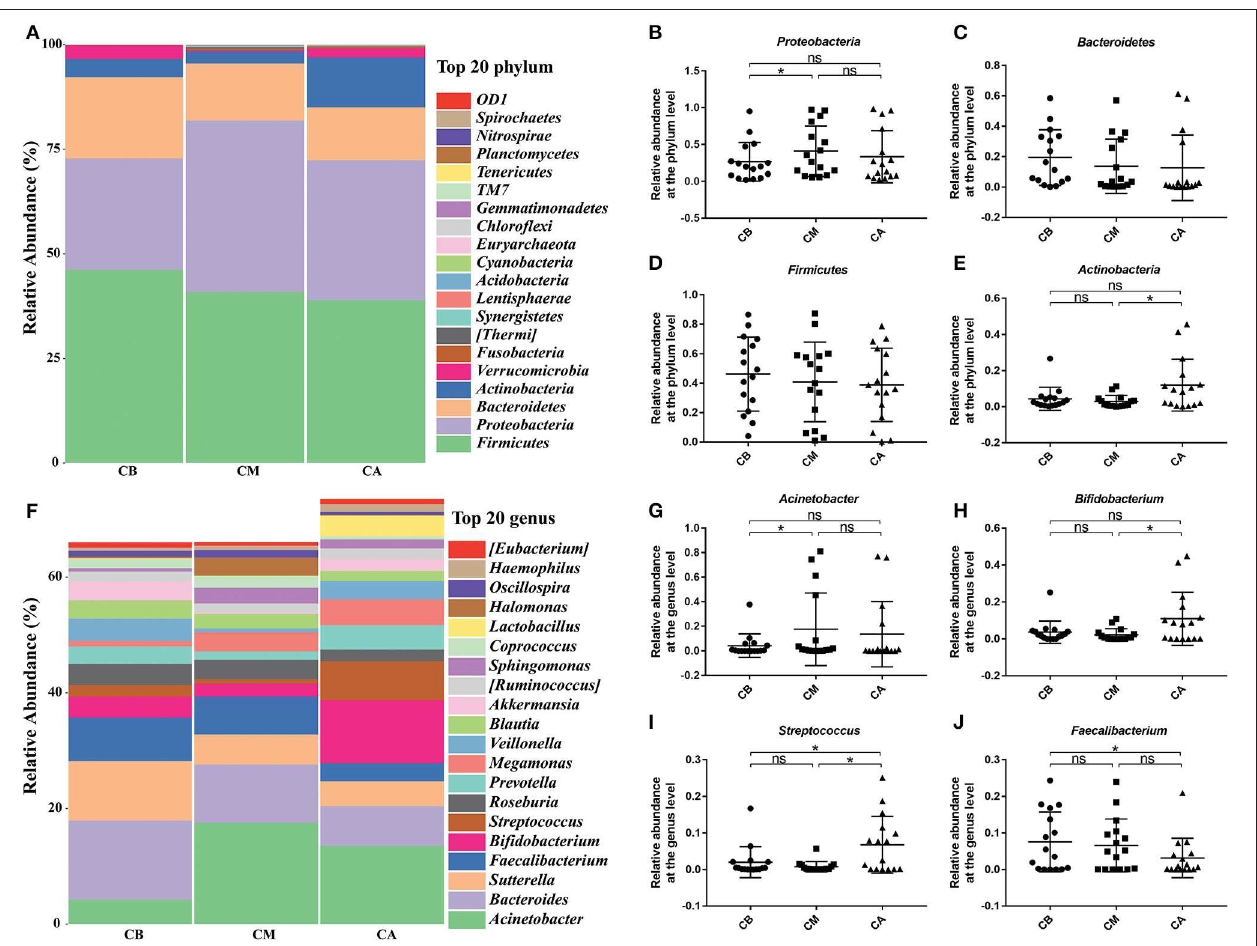
FIGURE 2 | Effect of bowel preparation on microbial composition at phylum and genus levels. (A) , the relative abundance of intestinal microbiota at the phylum level; (B) , Proteobacteria ; (C) , Bacteroidetes ; (D) , Firmicutes ; (E) , Actinobacteria . (F) , the relative abundance of intestinal microbiota at the genus level; (G) , Acinetobacter ; (H) , Bifidobacterium ; (I) , Streptococcus ; (J) , Faecalibacterium . CB, control group 3 days before bowel preparation ( n = 16); CM, control group during bowel preparation ( n = 16); CA, control group 5–7 days after bowel preparation ( n = 16). Data are presented as means ± SD. ns, P > 0.05; * P < 0.05.